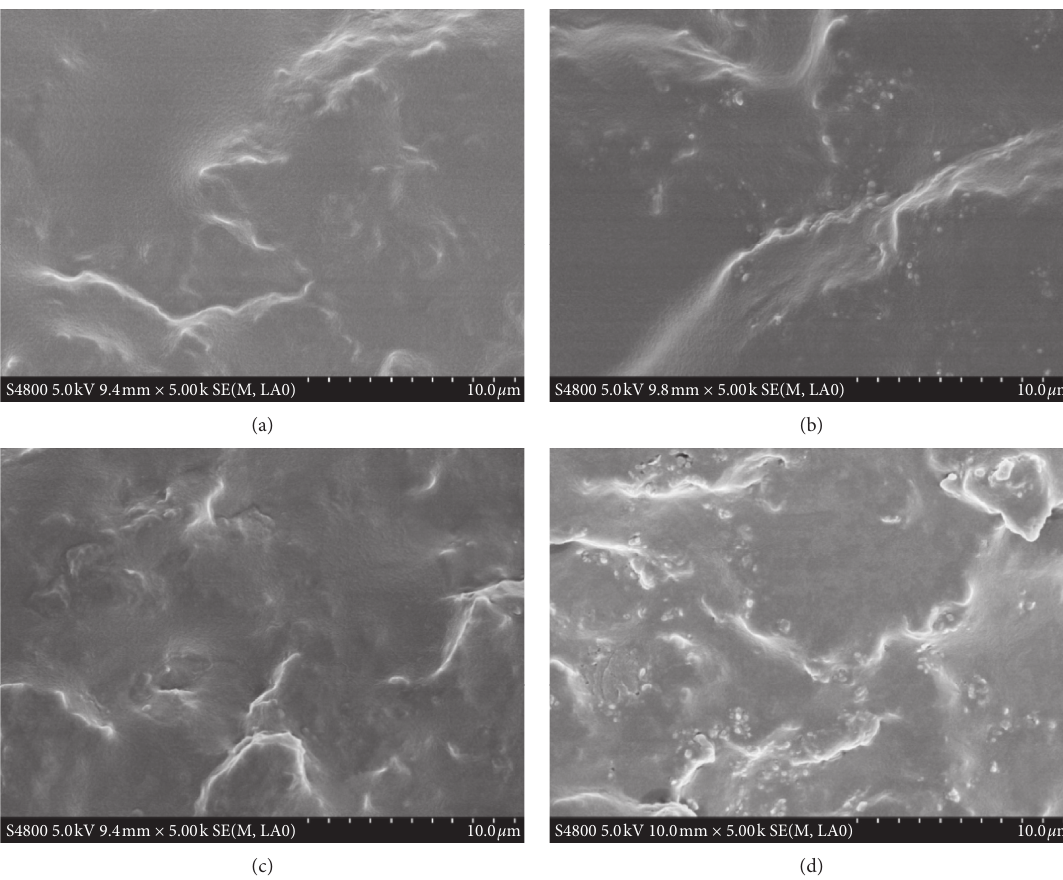
Figure 4: SEM images of samples of (a) original TPE, (b) TPE with MGST, (c) TPE with PTFE, and (d) TPE with MGST and